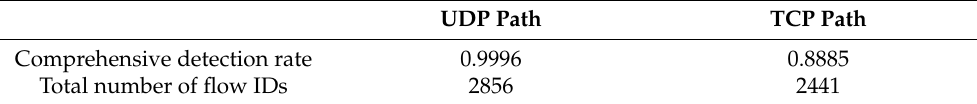
Table 8. Comprehensive detection rate.